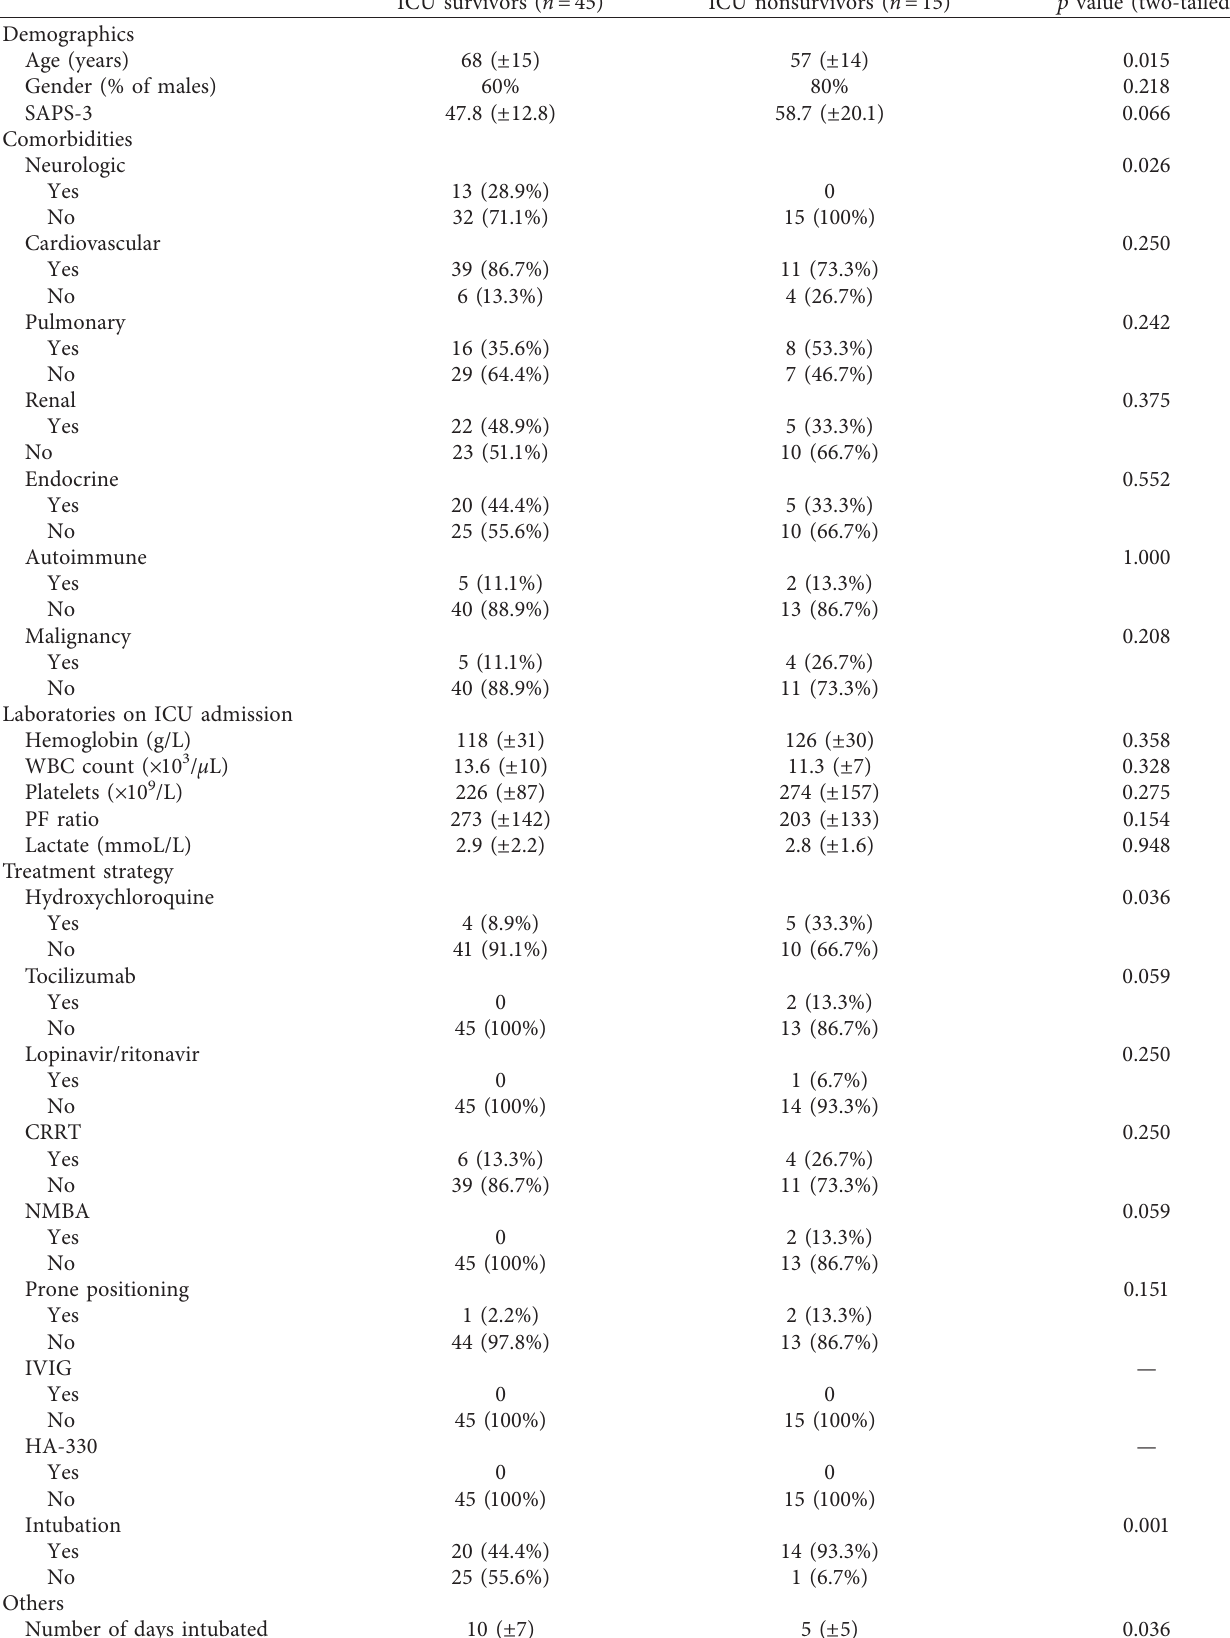
Table 5: Variables and outcomes among non-COVID-19